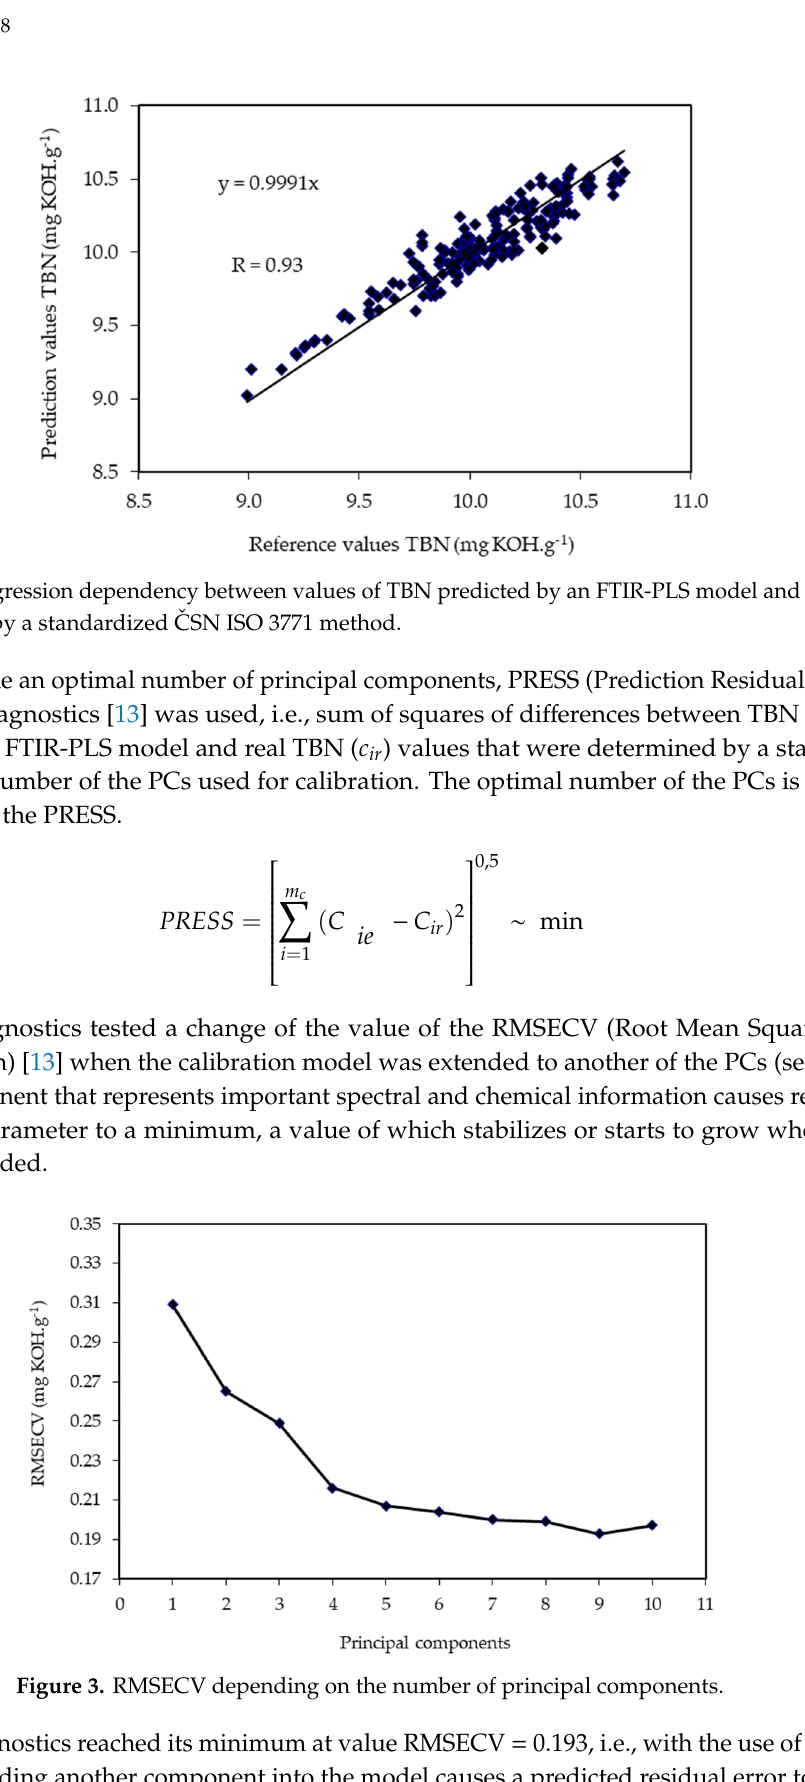
Figure 3. RMSECV depending on the number of principal components .